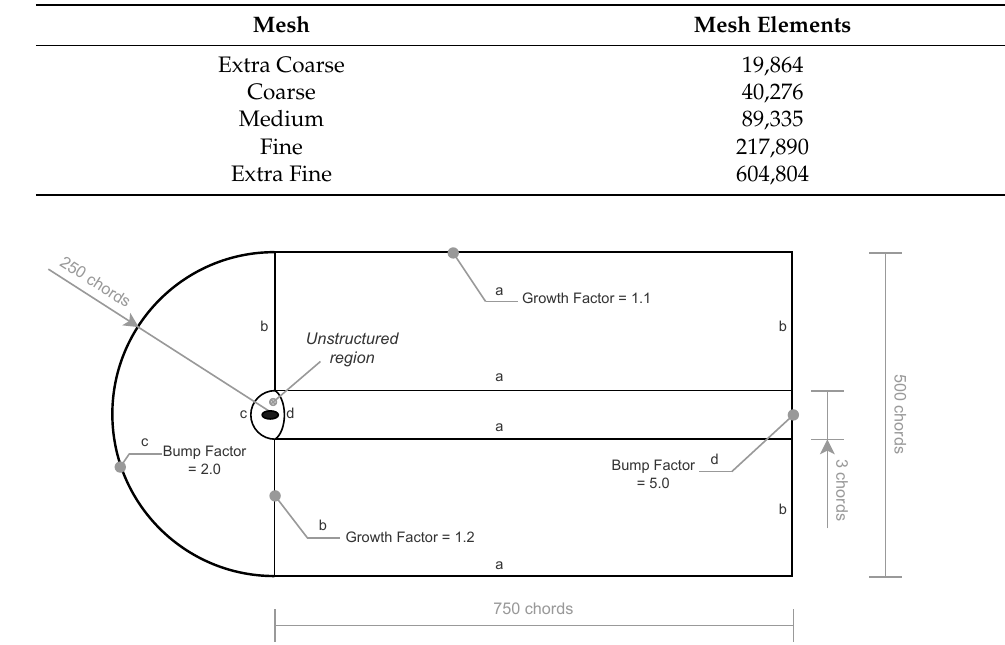
Figure 3. Overall mesh strategy and